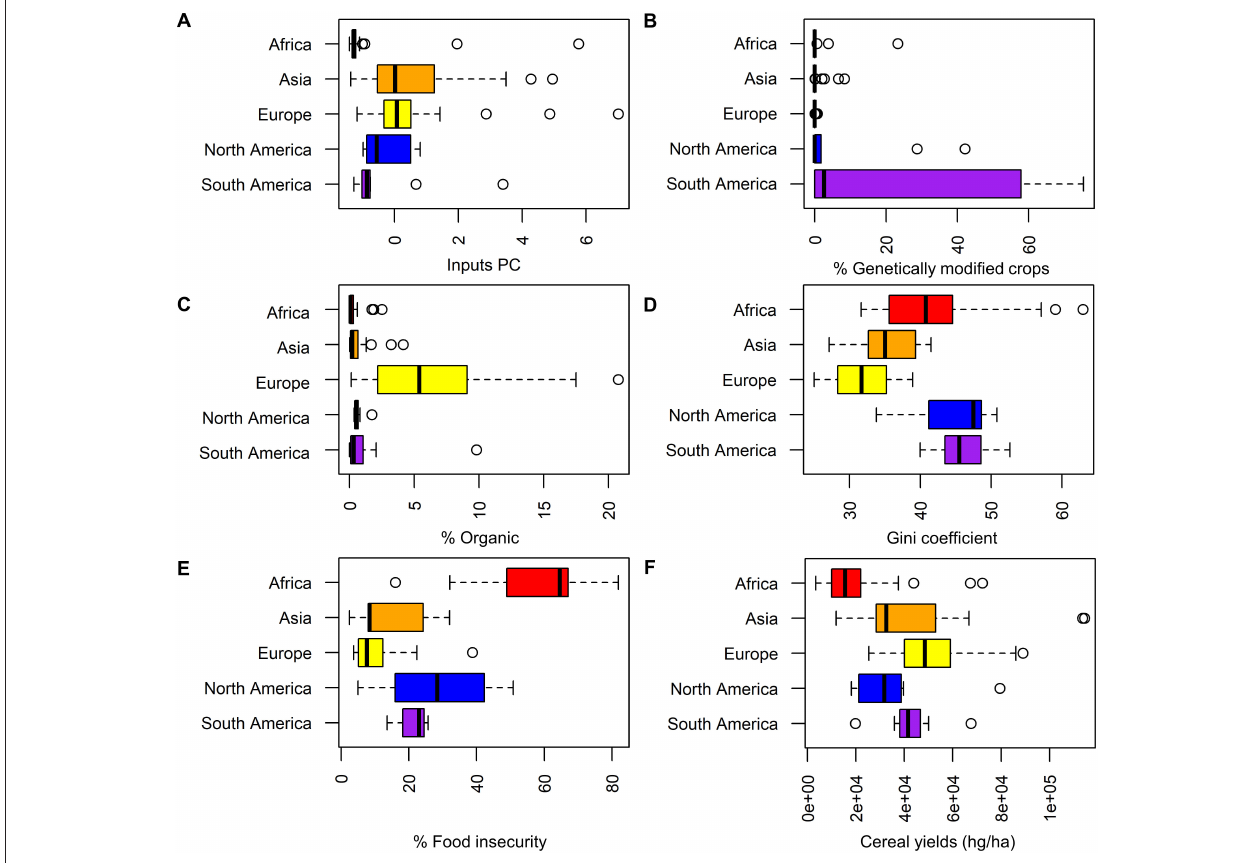
FIGURE 2 | Distribution of production strategies, income inequality, yields, and food insecurity by continent. Boxplots show all continents with over five countries represented in our dataset. (A) Inputs PC, (B) percentage of cropland in genetically modified (GM) crops, (C) percentage of organic agriculture, (D) Gini coefficient of income inequality (0 = perfect equality; 1 = perfect inequality), (E) prevalence of moderate to severe food insecurity, and (F) cereal yield